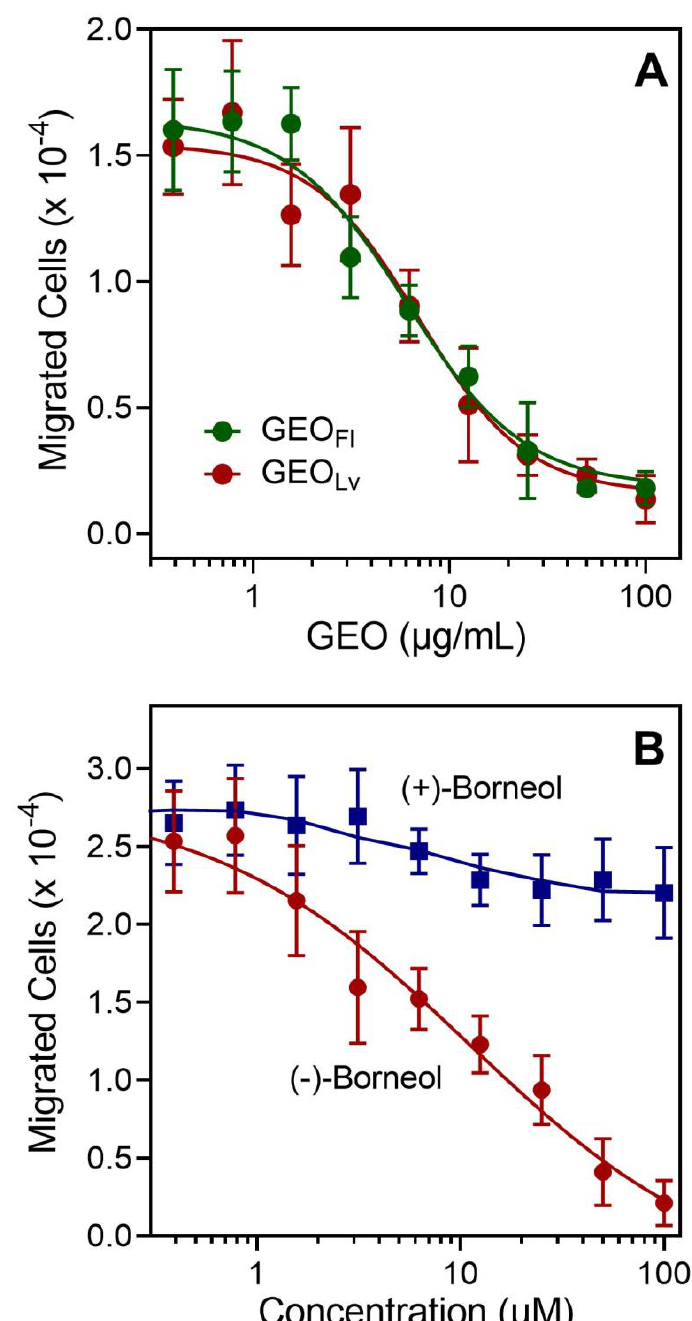
Figure 3. Effect of Grindelia essential oils or borneol on human neutrophil chemotaxis. Neutrophils were pretreated with the indicated concentrations of GEO Fl and GEO Lv ( A ) or ( − )-borneol and (+)-borneol ( B ), and neutrophil migration toward 1 nM f MLF was measured, as described. The data are from one experiment that is representative of three independent